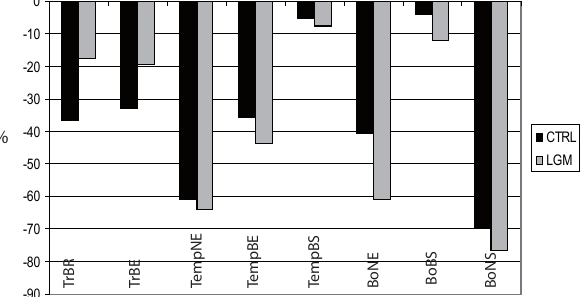
Fig. 14. Percentage of change in the area of presence of the tree PFT (fraction exceeds 1%) when the CO 2 is decreased from 310 to 185ppm and the background climate is kept constant to CTRL present or LGM. Abbreviations: see Table 1.